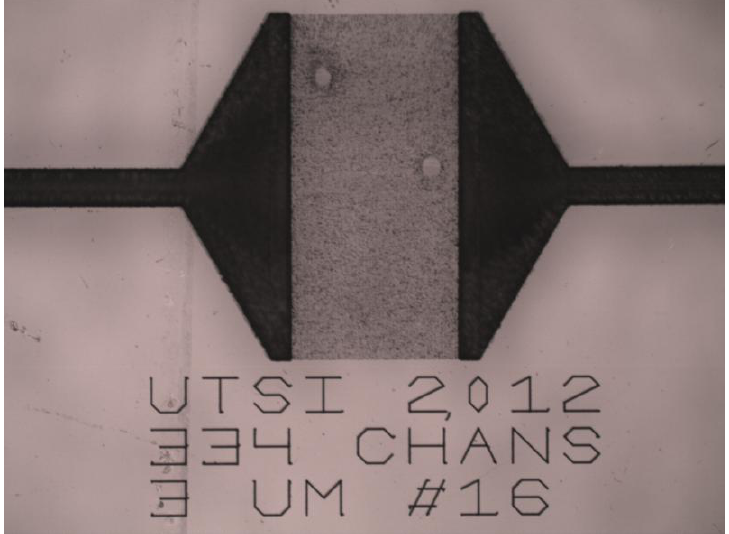
Figure 1. Optical micrograph of microchannels machined in SiO in hot 10 M KOH solution. The large, flared dark areas on the right and left sides are the macrochannels leading to the access wells (not shown).